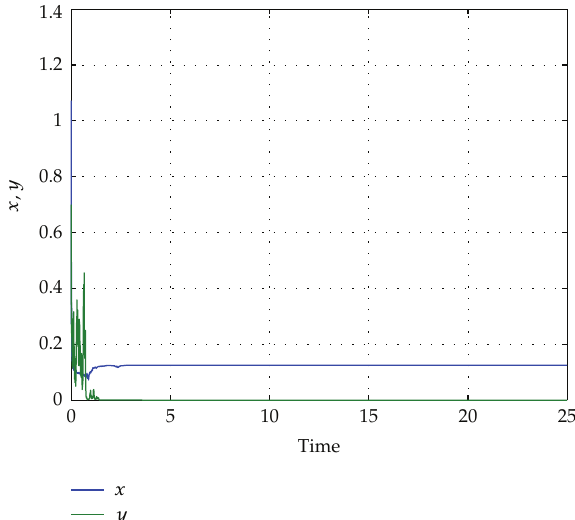
Figure 5: The solution of the stochastic model (cid:4) 3.2 (cid:5) . The parameters are taken as α (cid:6) 2 , β (cid:6) 4, a (cid:6) 2 , b (cid:6) 0 . 25 , c (cid:6) 0 . 875 , e (cid:6) 1 , m (cid:6) 0 . 95 , n (cid:6) 0 . 9 , and f (cid:6) 0 . 8.